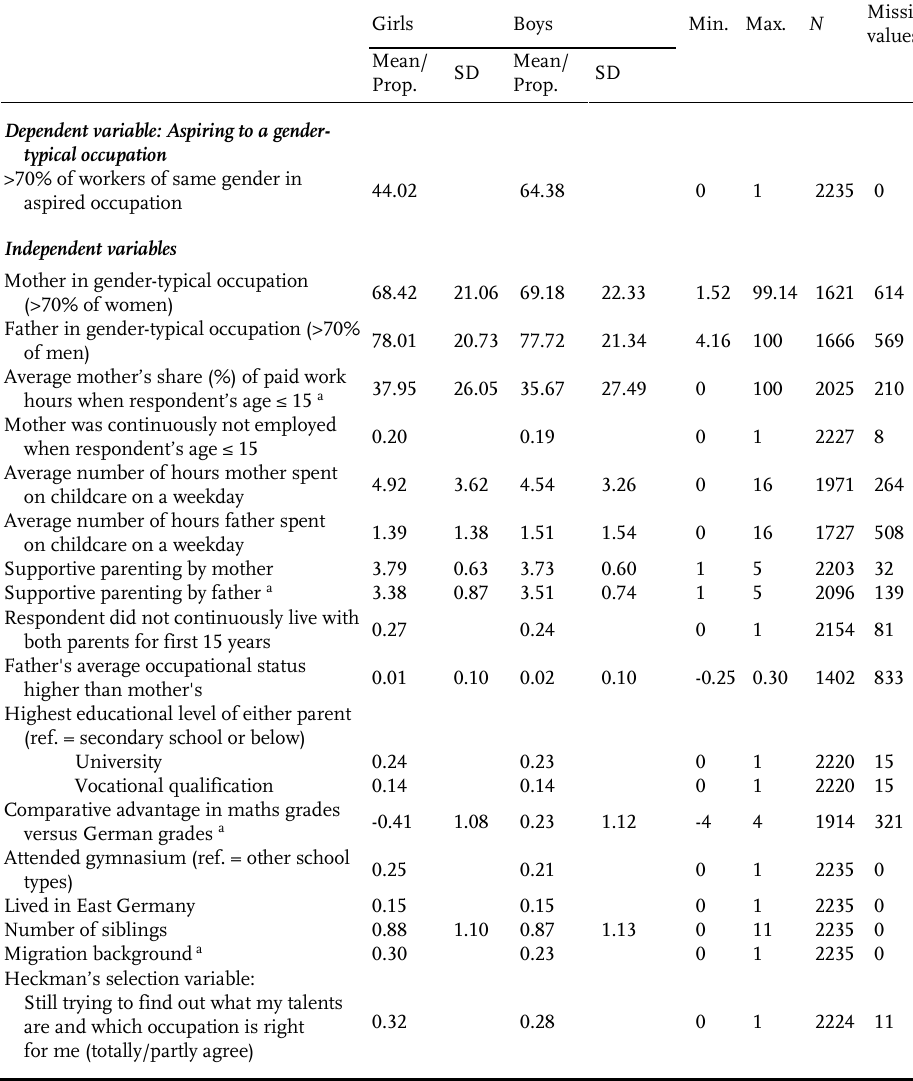
Table 1 : Respondent characteristics by gender: means and proportions